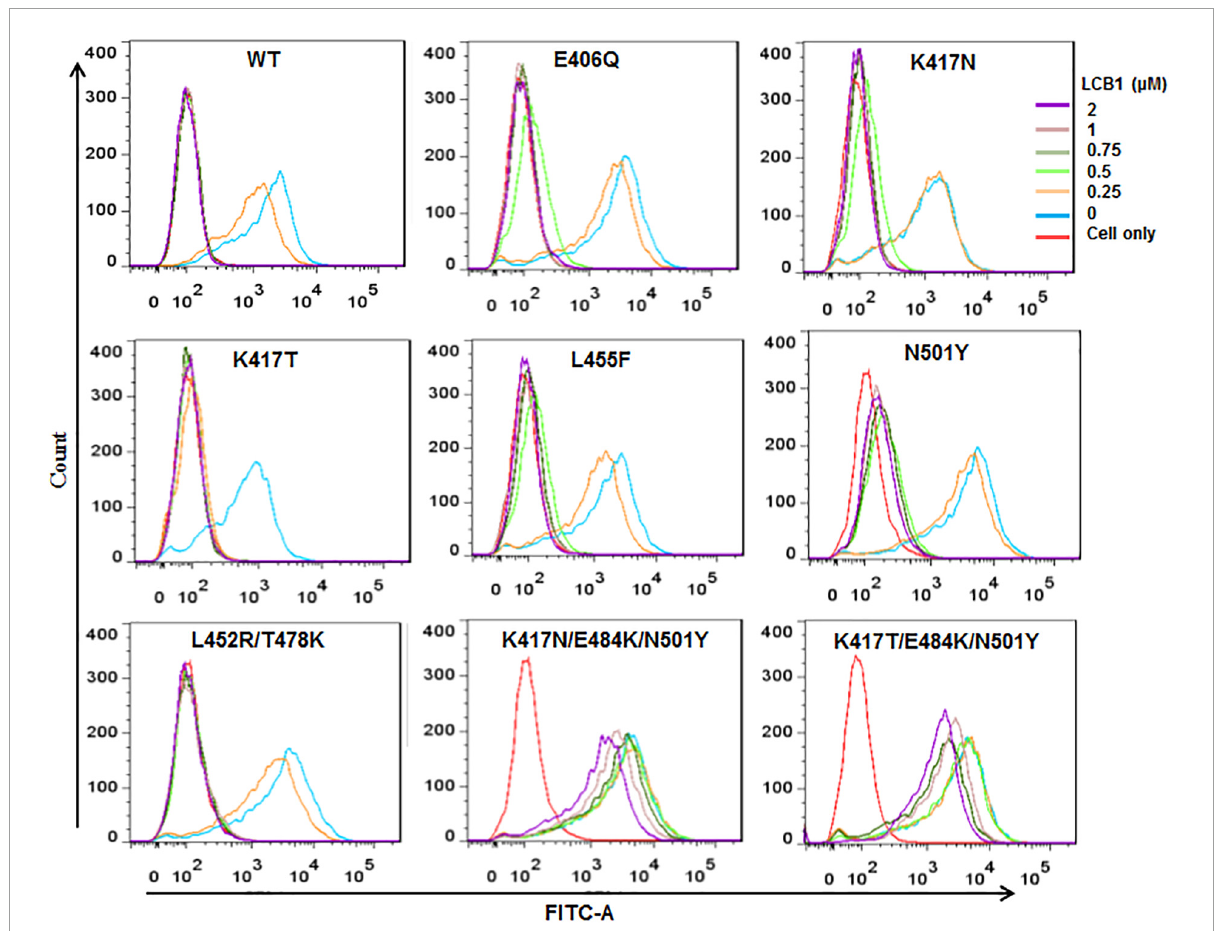
FIGURE4 The blocking activity of LCB1 on the binding of RBD protein with the cell receptor ACE2. An His-tagged RBD protein was incubated with serially diluted LCB1 and then added to 293T/ACE2 cells for incubation. The bound RBD was detected by an Alexa Fluor 488-labeled rabbit anti-His tag antibody with FACS